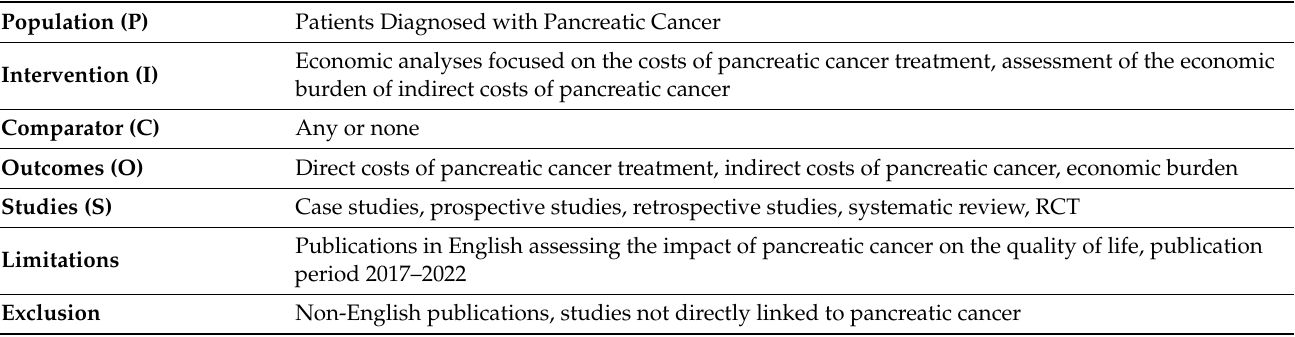
Table 1. Criteria for inclusion of publications according to the PICO